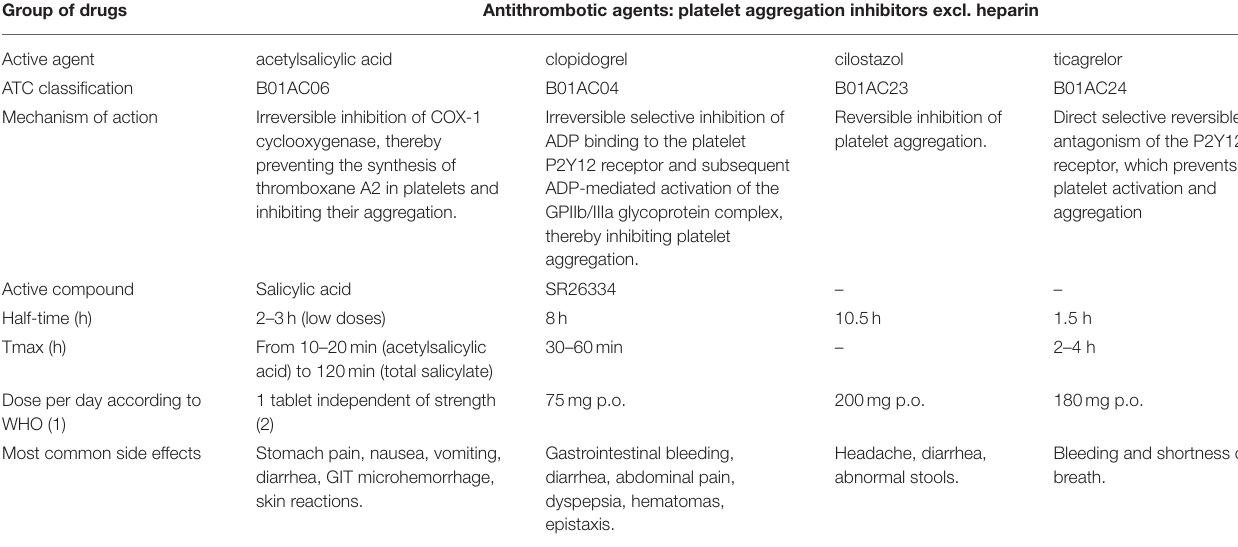
TABLE 1 | Antithrombotic agents: platelet aggregation inhibitors (B01AC) (20, 21). Group of